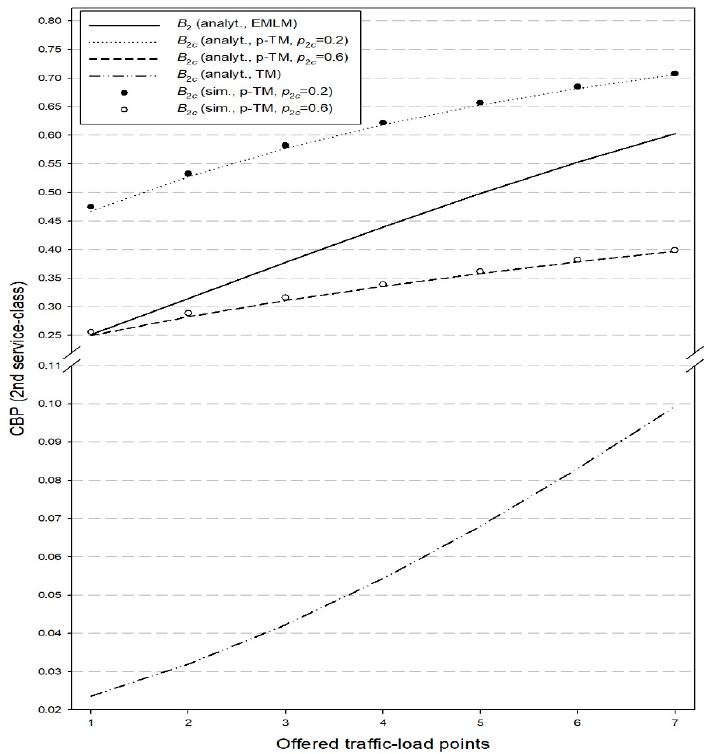
Figure 6. CBP—Second service-class (probabilistic threshold loss model).